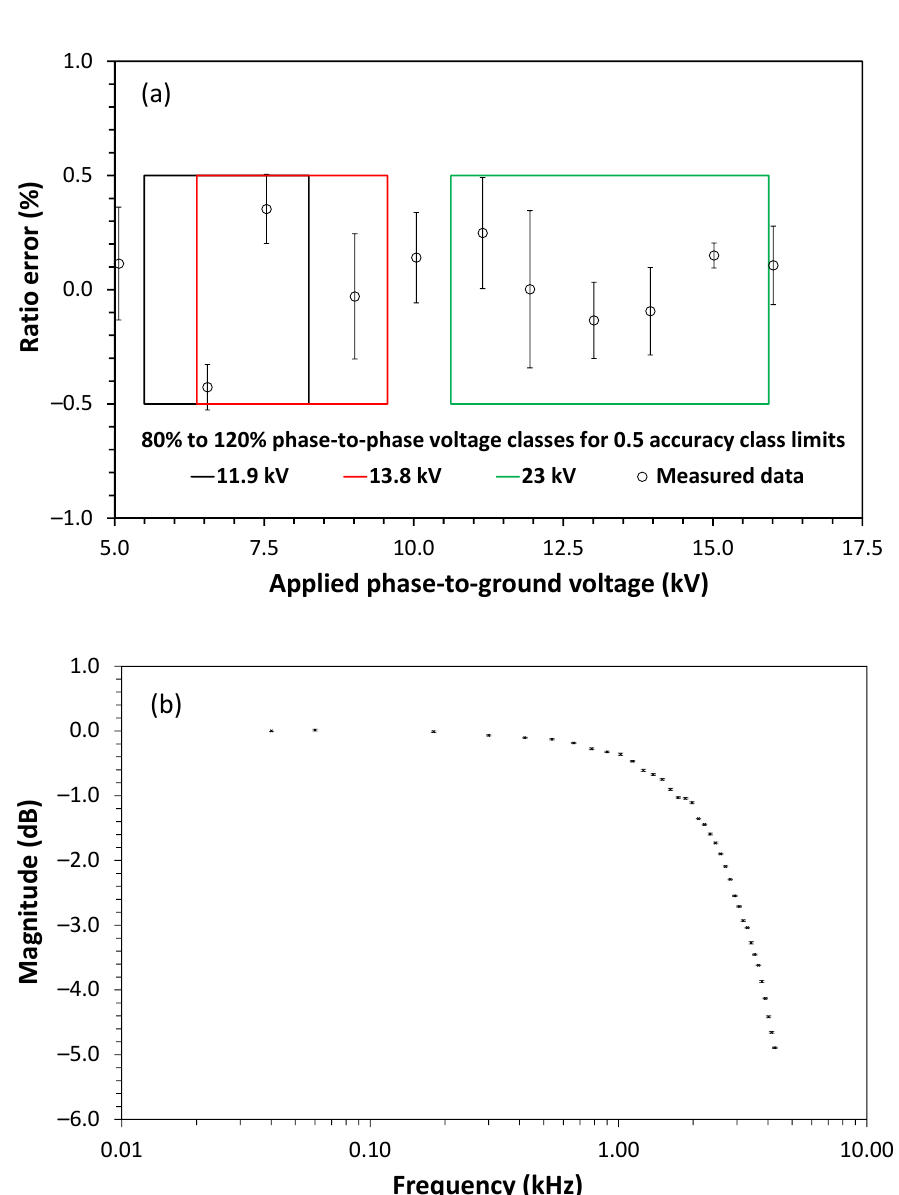
Figure 7. Voltage sensor characterization: ( a ) ratio error and ( b ) bandwidth.